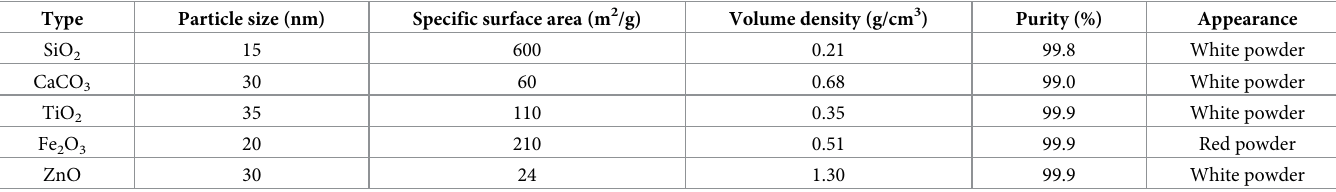
Table 2. Particle size and specific surface area of the selected